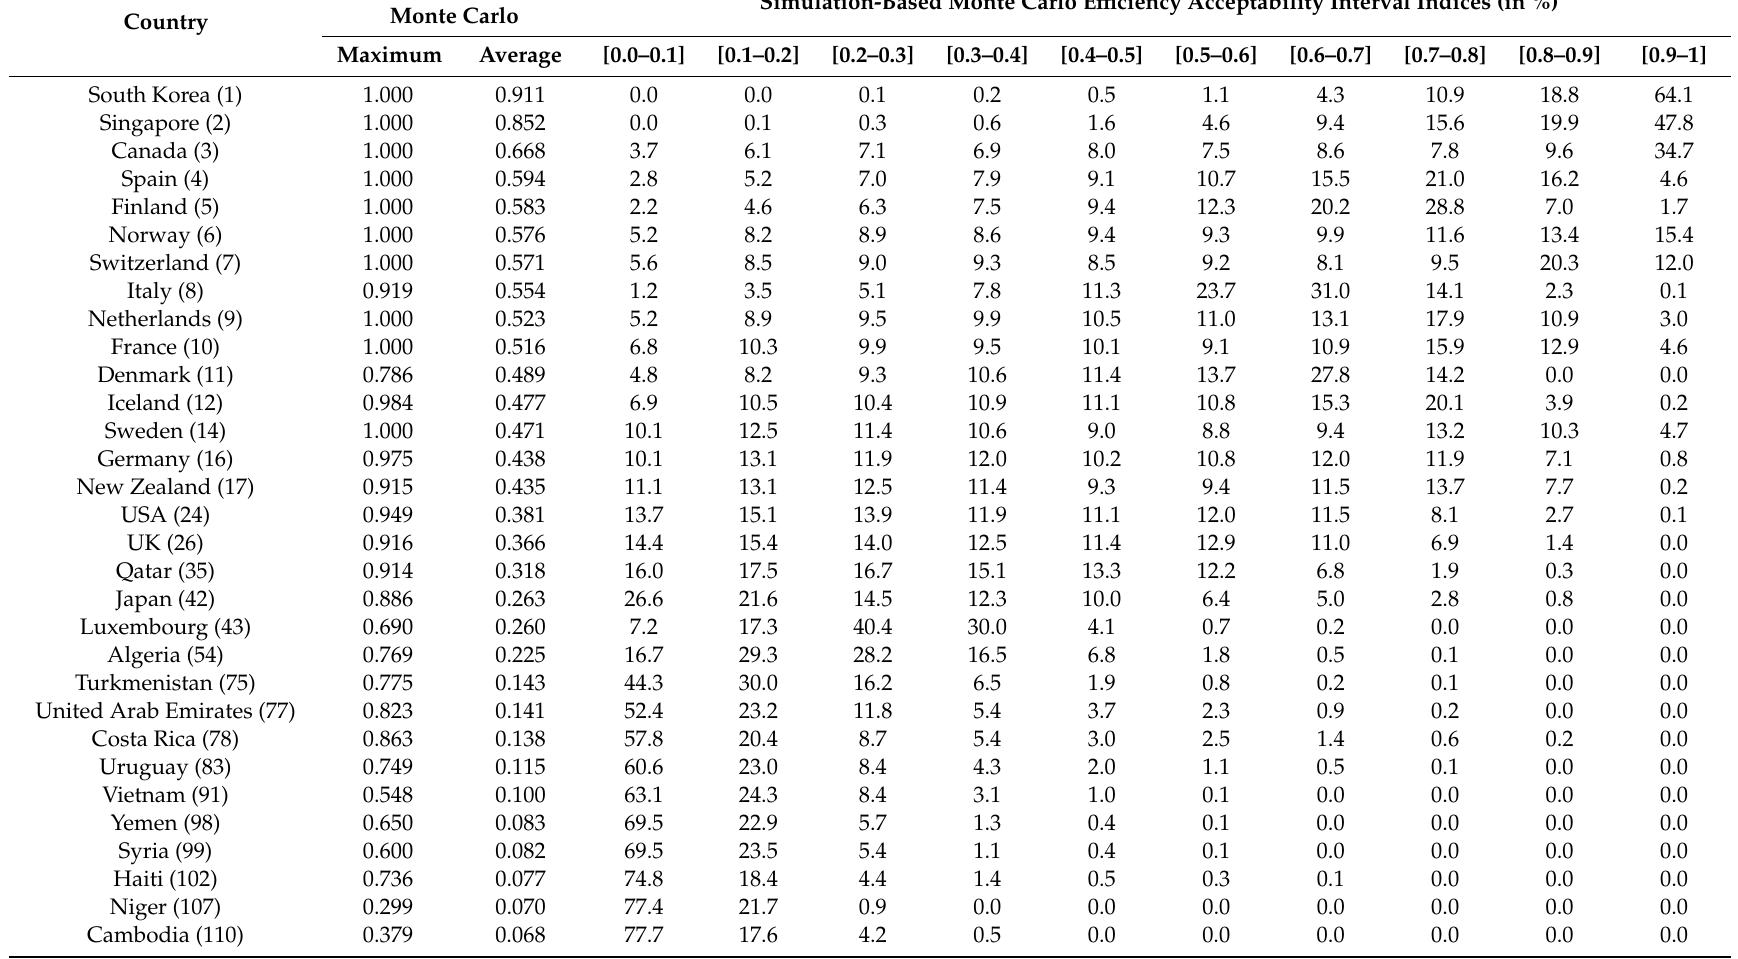
Table 8. Maximum and average e ffi ciency scores for the robust e ffi ciency analysis model, as well as the e ffi ciency acceptability interval indices. The number after the countries’ names corresponds to their ranks computed based on the average e ffi ciency. The full table for all countries is available in the ESI, Table S7.